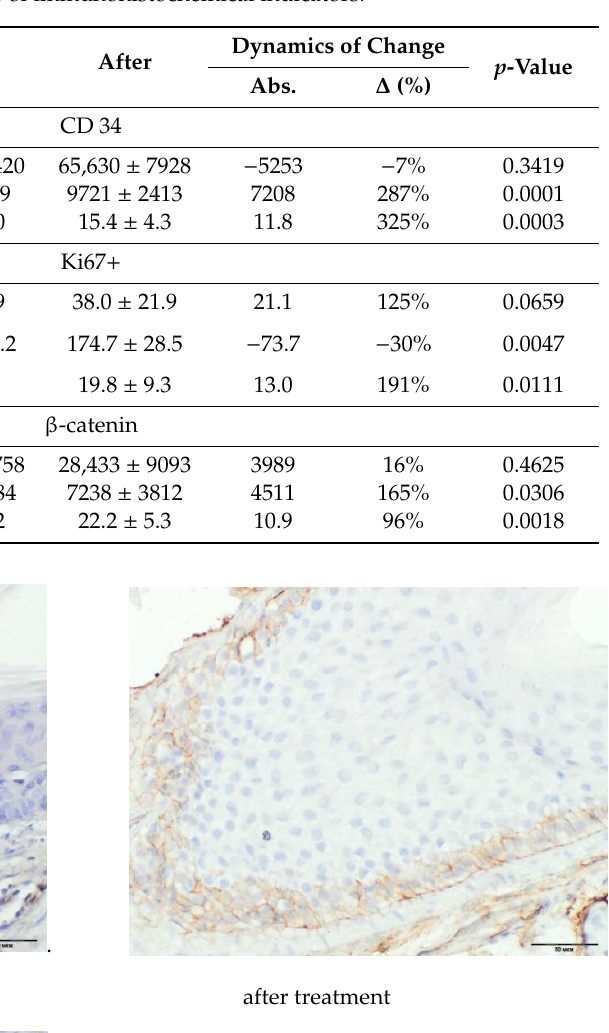
Table 7. Dynamics of immunohistochemical indicators.